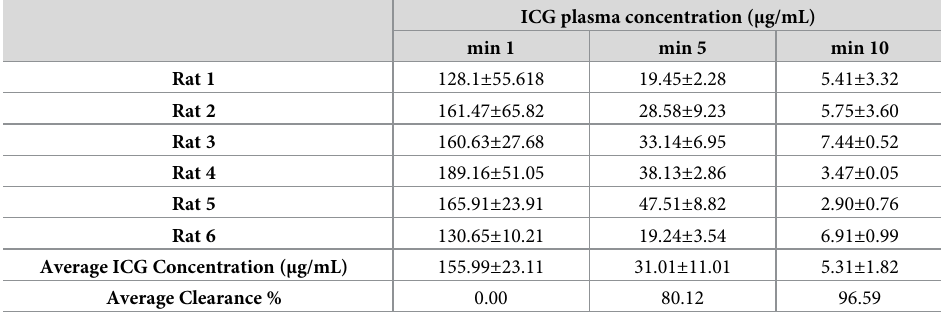
Table 3. Indocyanine green plasma clearance (ICG) rate.